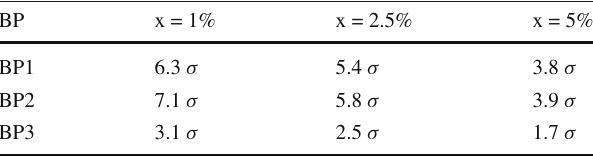
Table 11 Signal significance for the benchmark points at 13 TeV with L = 3000 fb − 1 , in the γγ + / E T final state, using ANN with 1%, 2.5% and 5% systematic uncertainty